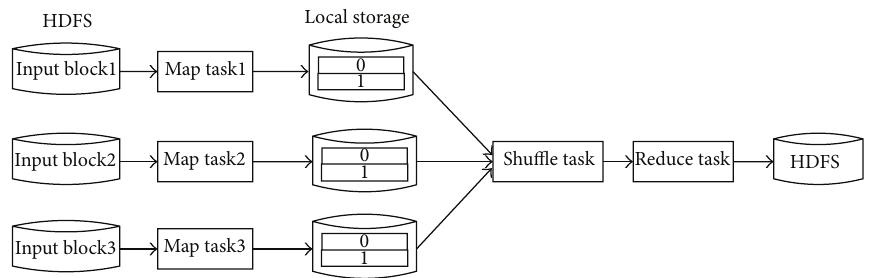
Figure 1: The interaction figure of HDFS and